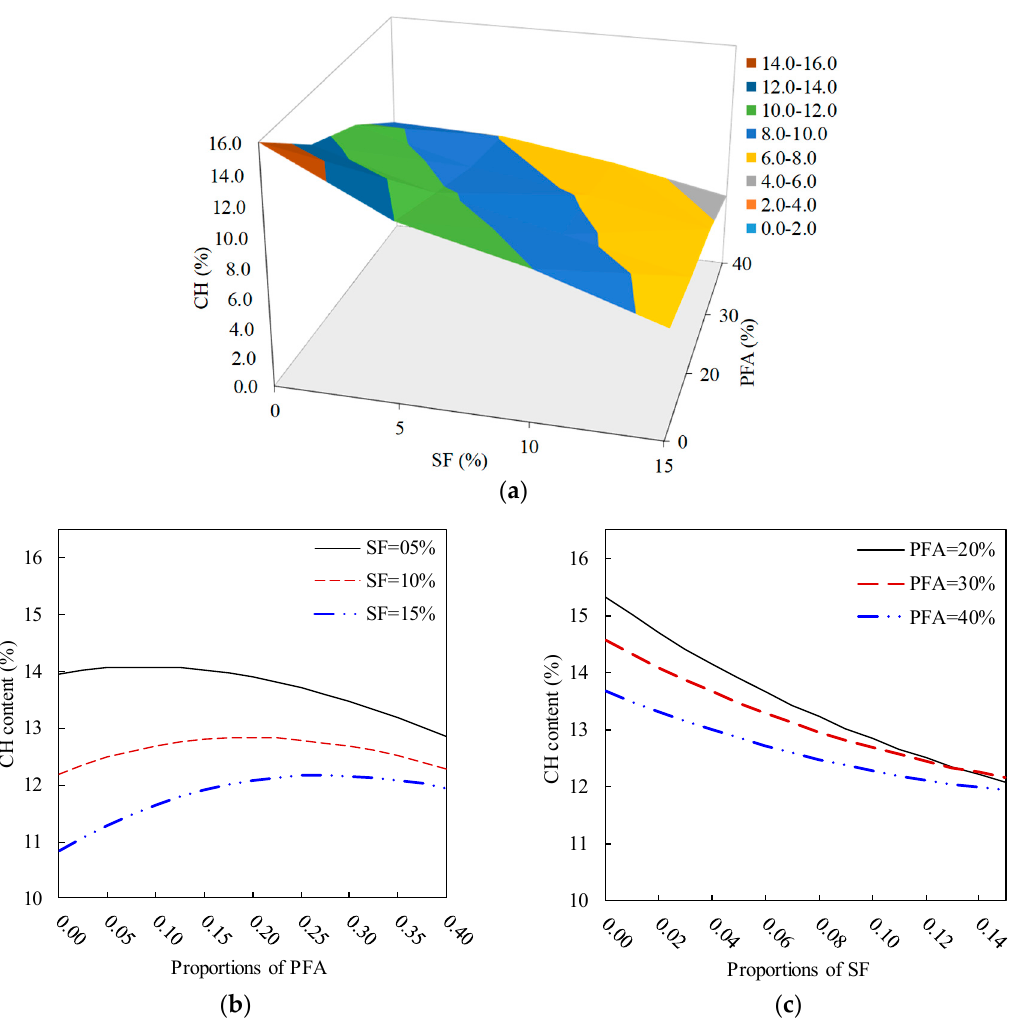
Figure 8. Effect of the PFA and SF on the CH content of ternary blended systems. ( a ) response surface, ( b ) constant SF, ( c ) constant PFA.